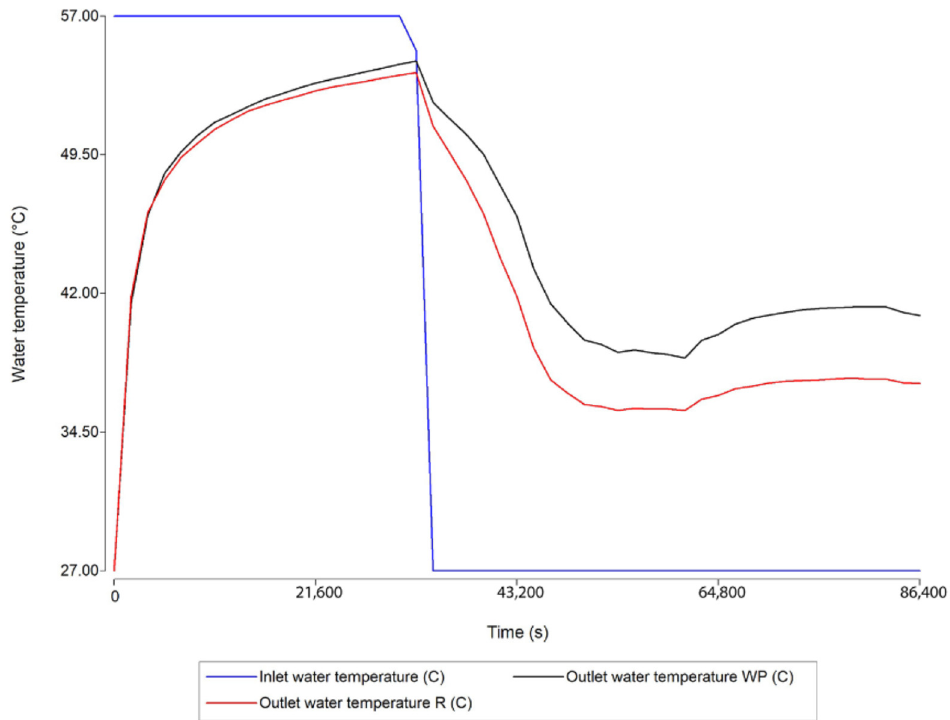
Figure 8. Variation in inlet and outlet water temperatures for reference TES with PCM (R) and TES without PCM (WP) (Copyright 2021 Bernal et al. (https://creativecommons.org/licenses/by/4.0/), accessed on 26 September 2022 [50].